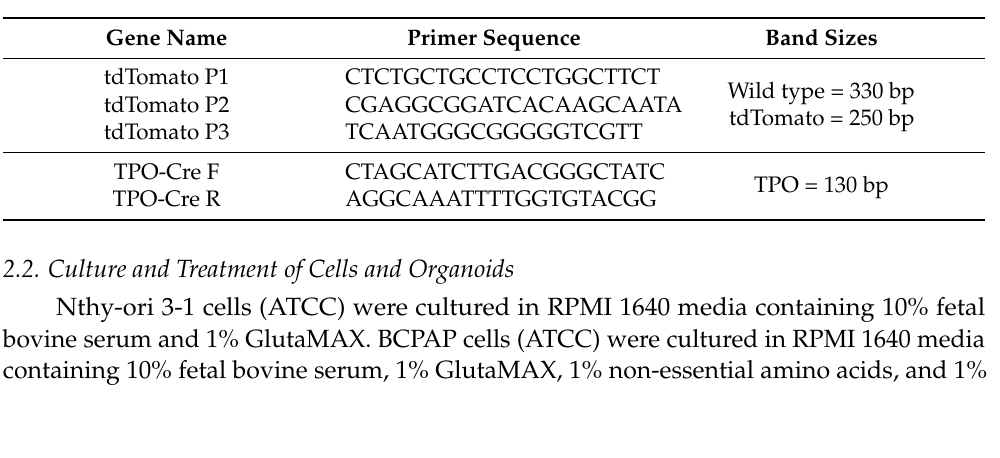
Table 1. Primer information for